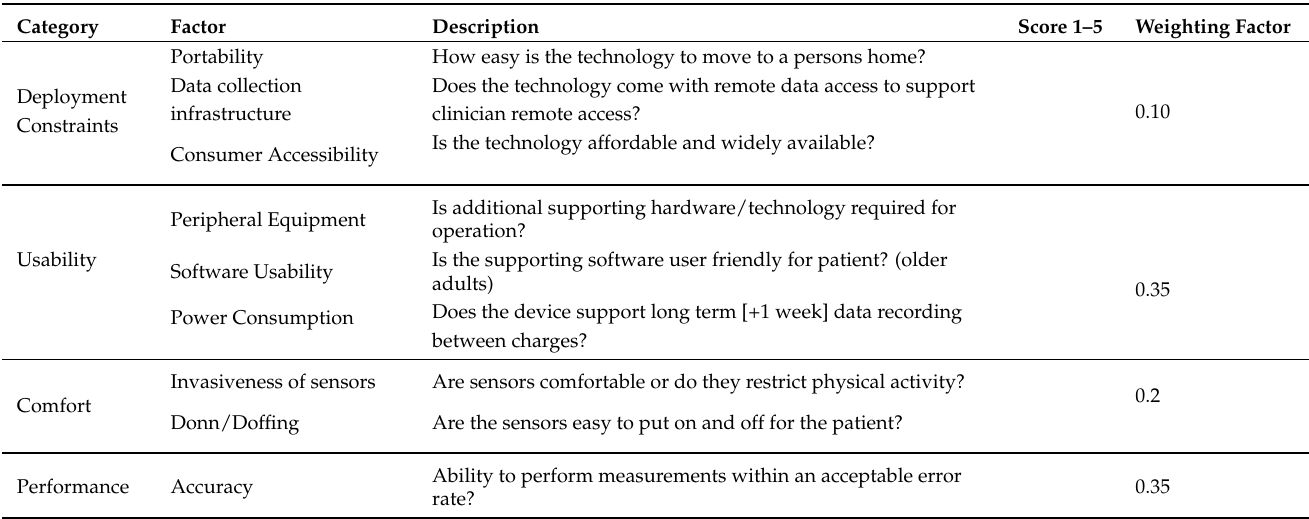
Table 2. Grading